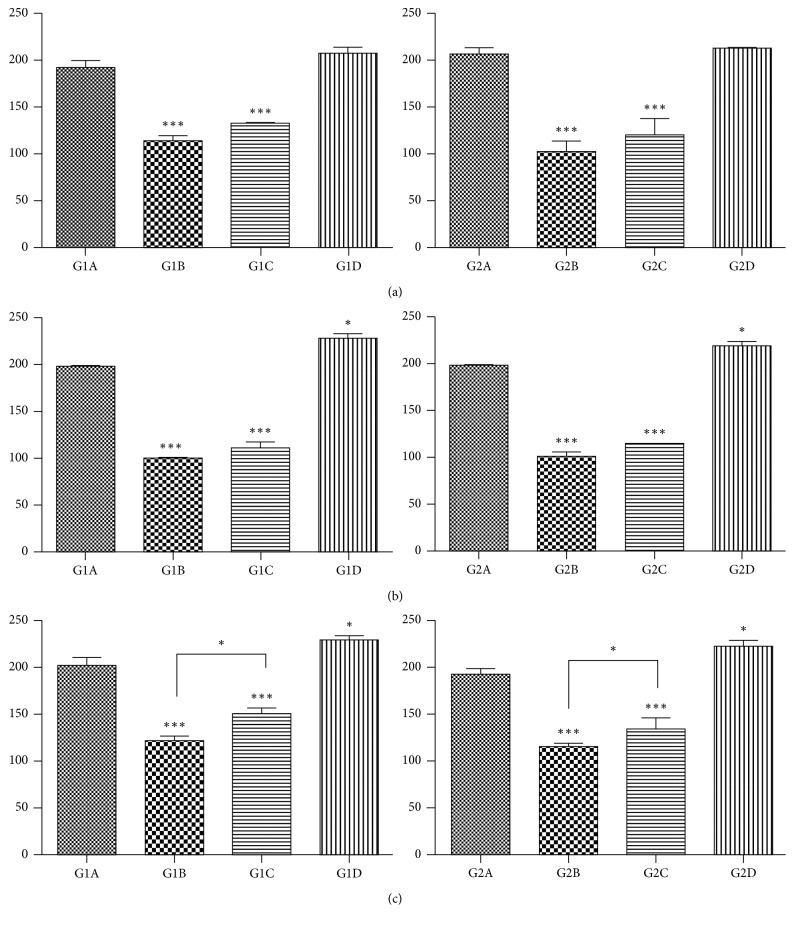
Statistical evaluation of 3βHSD (a), INSL3 (b), and GPRC6A (c) immunoreactivity scores of Leydig cells in testicular tissue sections of Group 1 and Group 2 subjects. ∗∗∗p < 0.0001; ∗∗p < 0.001; ∗p < 0.01.